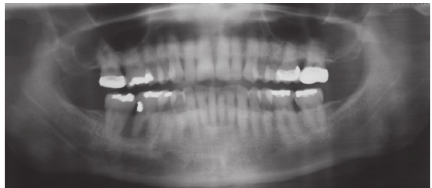
Figure 1: Panoramic radiograph at the initial appointment (#30 was extracted by the referring